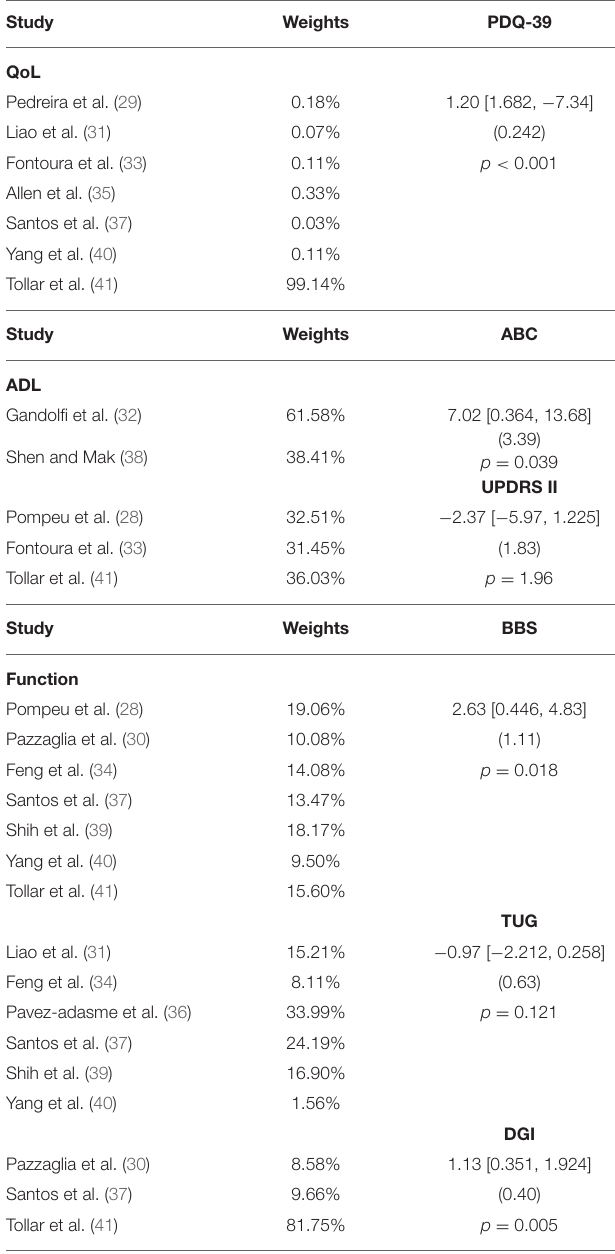
TABLE 4 | Results of the